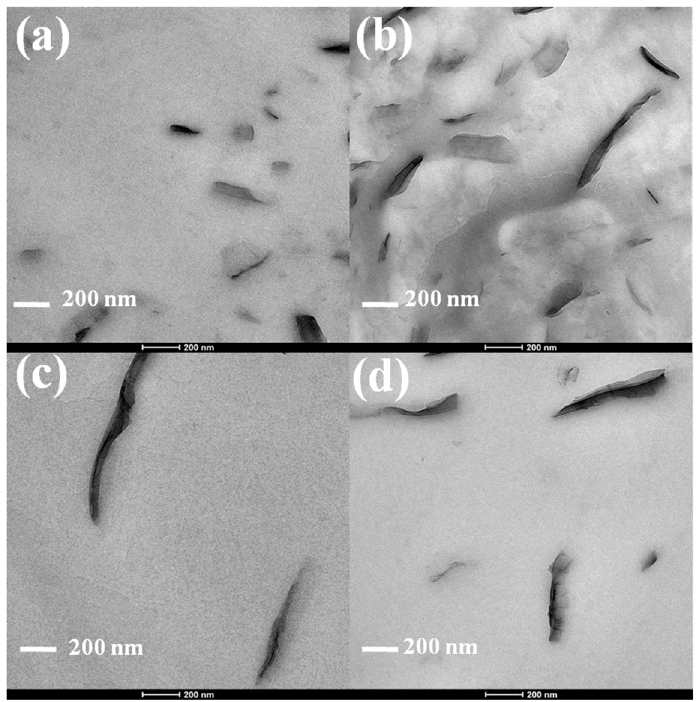
Figure 2. TEM images of ( a ) PLA/ETOVMT-2, ( b ) PLA/ETOVMT-5, ( c ) PLA/C18VMT-2, ( d ) PLA/C18VMT-5.